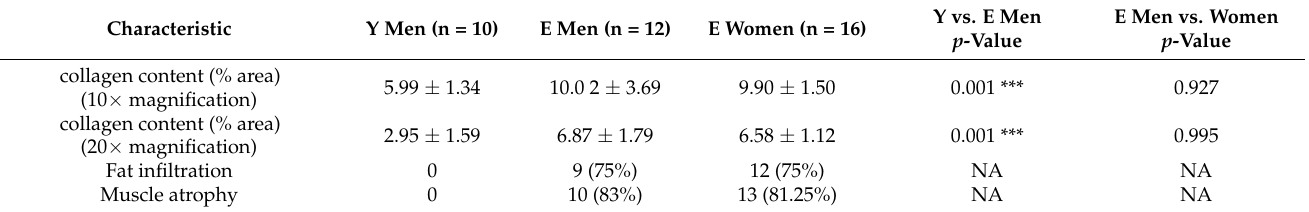
Table 2. The collagen component in the ECM of the IMCT of the human skeletal muscle (n = 38). Characteristic